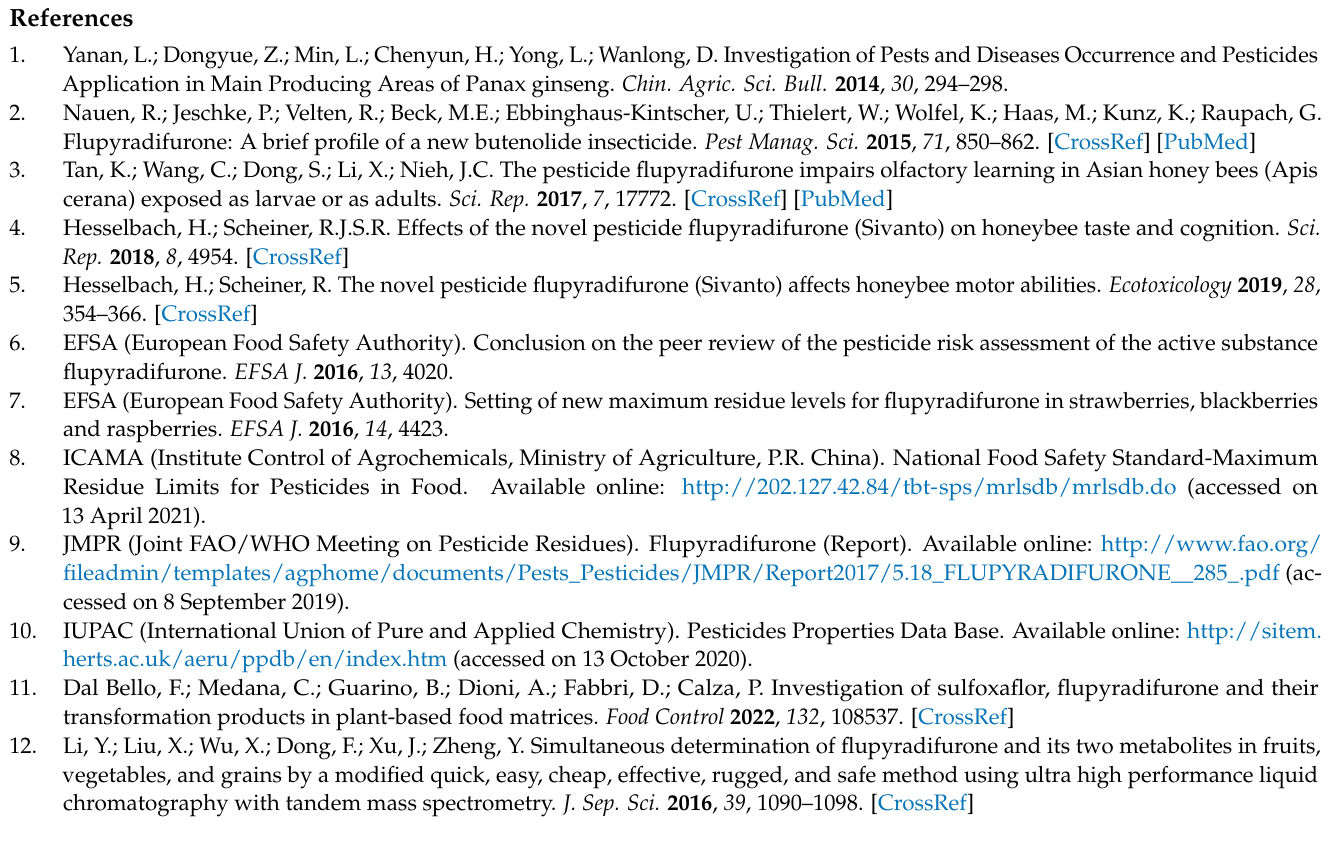
furone; Table S1: The MRM and gradient elution conditions for analysis of flupyradifurone, DFA and 6-CNA; Table S2: The parameters for the ESI source in HPLC-MS/MS; Table S3: Mean recoveries and RSD for target compounds from different matrices at three spiked levels; Table S4: Calibration information of FPF, 6-CNA, or DFA in different matrices; Table S5: Terminal residues of FPF,